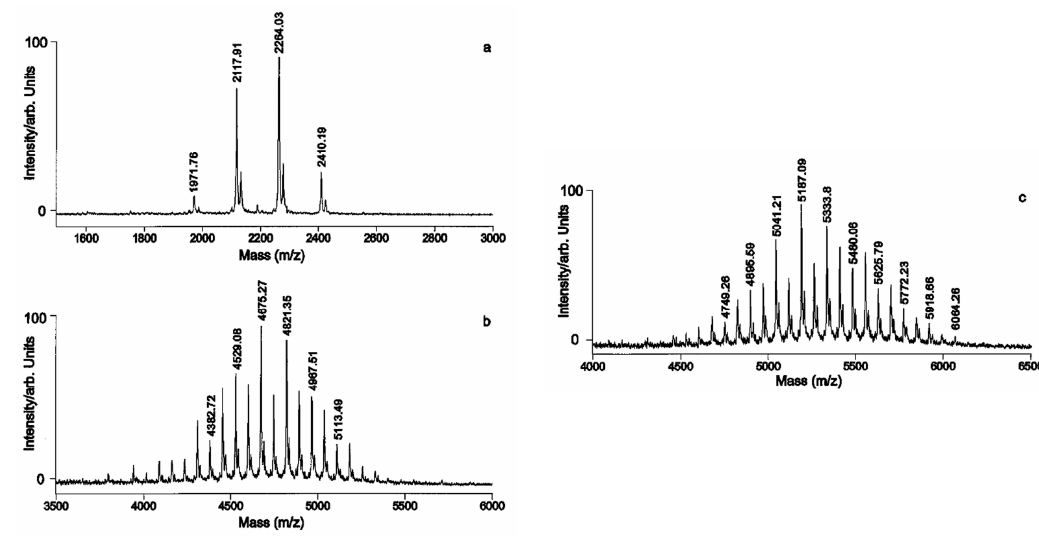
Figure 7. Linear positive-ion MALDI mass spectra of Bio-Gel P-6 fractions B, F and G (see Figure 6b). ( a ) Section of the mass spectrum of fraction B; ( b ) Section of the mass spectrum of fraction F; ( c ) Section of the mass spectrum of fraction G. Reproduced with permission from [46]. Copyright American Chemical Society, 1999.